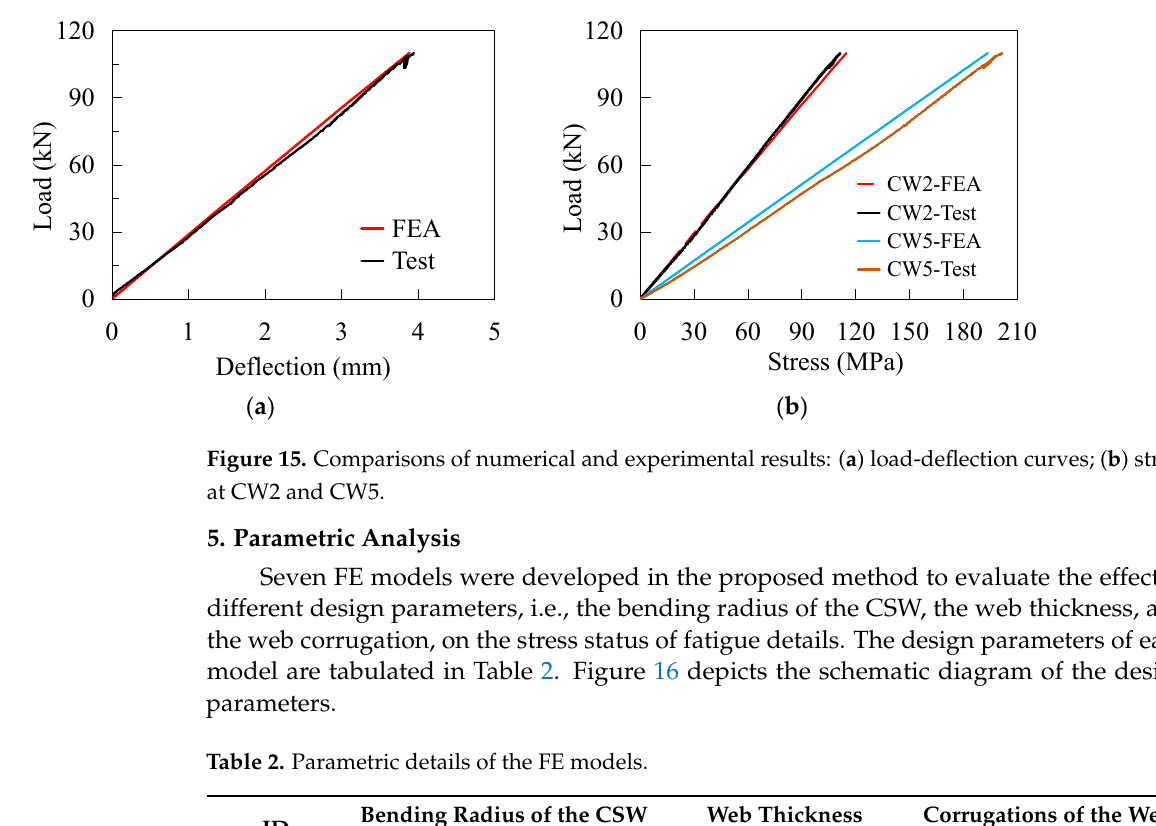
Figure 14. Stress nephogram of the FE model. (Unit: MPa).